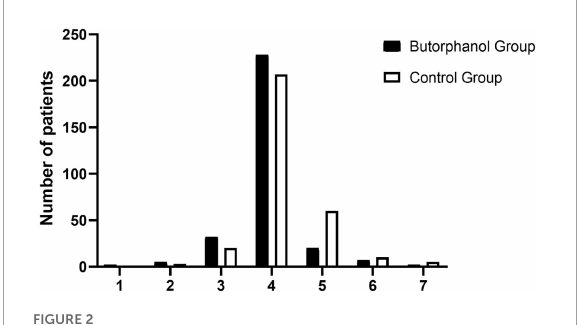
FIGURE2 Distribution of the Riker Sedation-Agitation Scale (RSAS) at 5 min after extubation. 1, minimal or no response to noxious stimuli; 2, arousal to physical stimuli but non-communicative; 3, difficult to arouse but awakens to verbal stimuli or gentle shaking; 4, calm and follows commands; 5, anxious or physically agitated but calms to verbal instructions; 6, requires restraint and frequent verbal reminding of limits; and 7, attempting to remove tracheal tube, or catheters, or striking at staff.